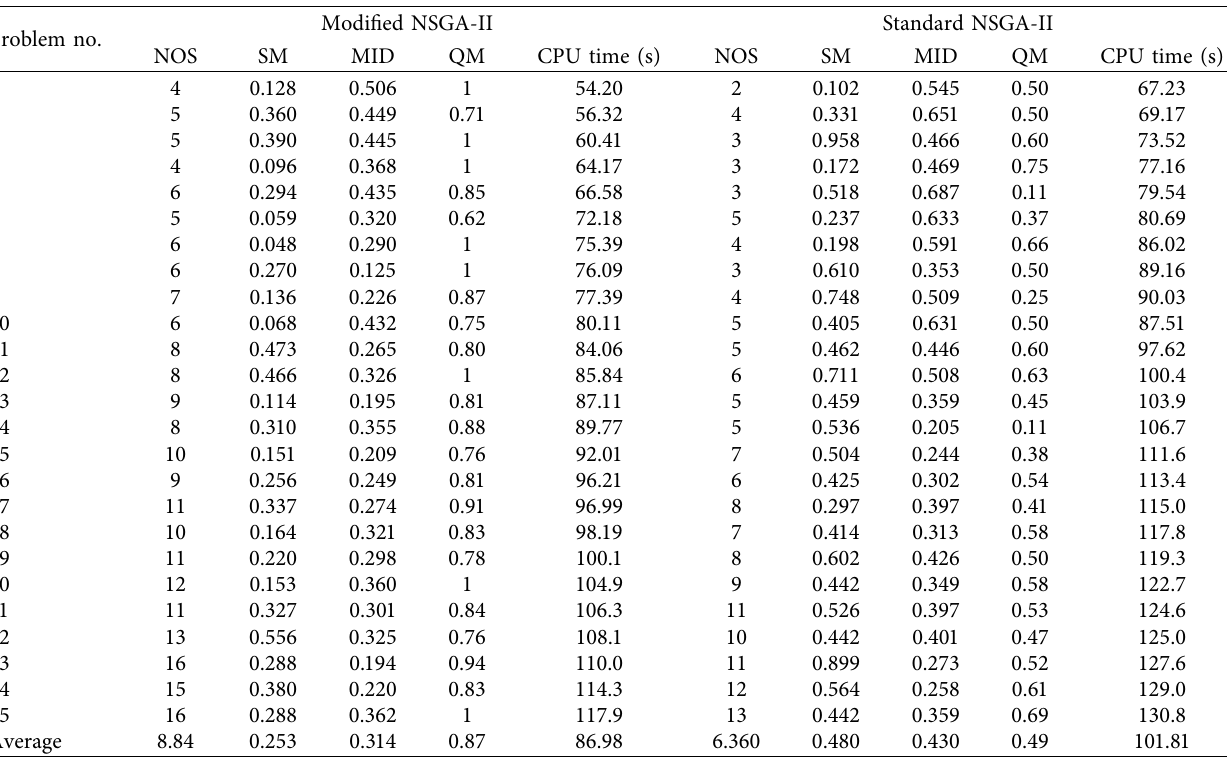
Table 4: Comparison metrics for different size instances.